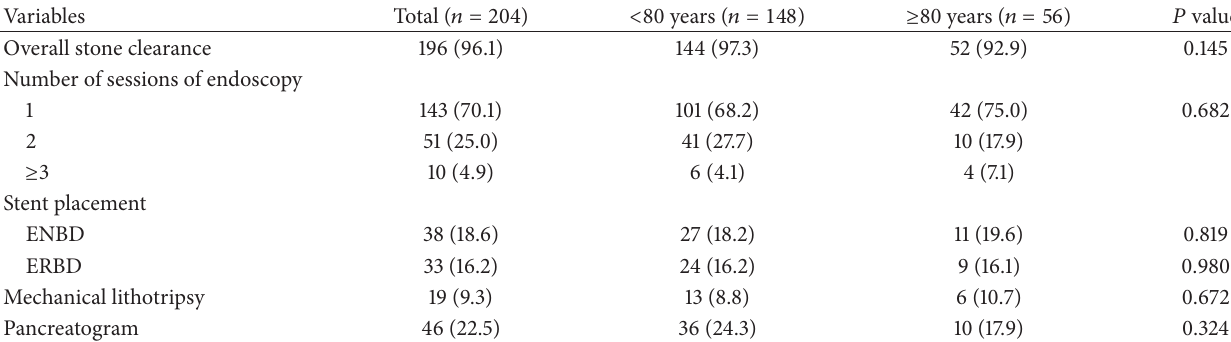
Table 2: Clinical outcomes of endoscopic retrograde